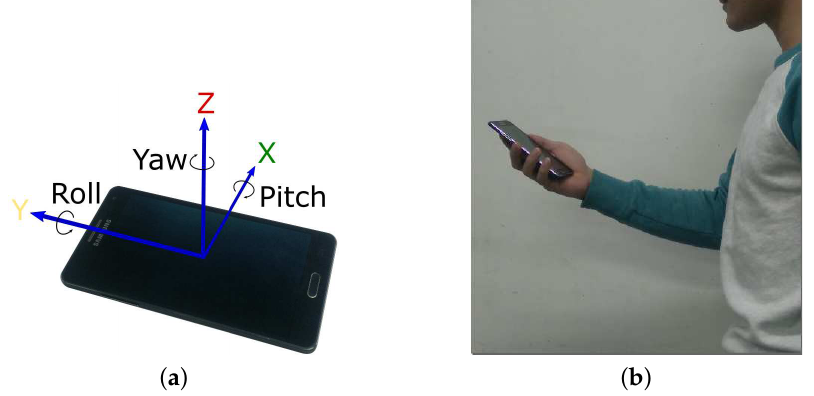
Figure 1. Experimental setup. ( a ) Axes definition; ( b ) Holding mode.